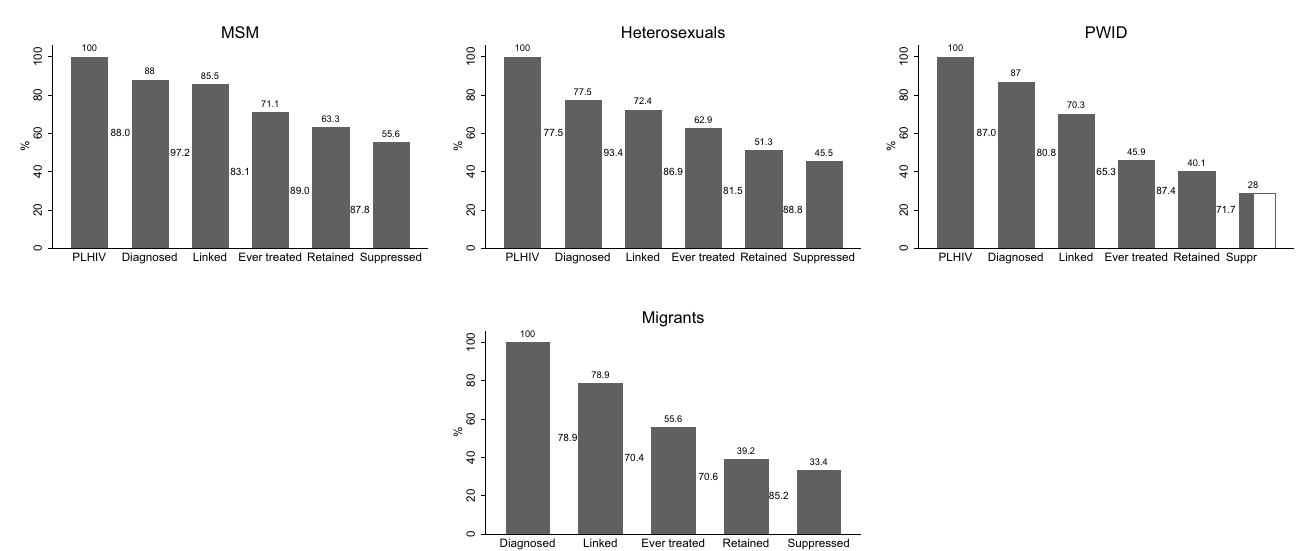
Fig 3. Cascade of care for men who have sex with men (MSM), people who inject drugs (PWID) and heterosexuals (A) and for migrants (B). The total number of migrants living with HIV could not be estimated; thus, the first stage of this CoC is the number of diagnosed migrants. The numbers between the bars correspond to proportion of the previous stage, while the numbers above the bars correspond to proportions of PLHIV for A and to proportions of diagnosed for B. Vertical lines on the top of the Diagnosed, Retained to care and Virally suppressed bars correspond to 95% Confidence Intervals.